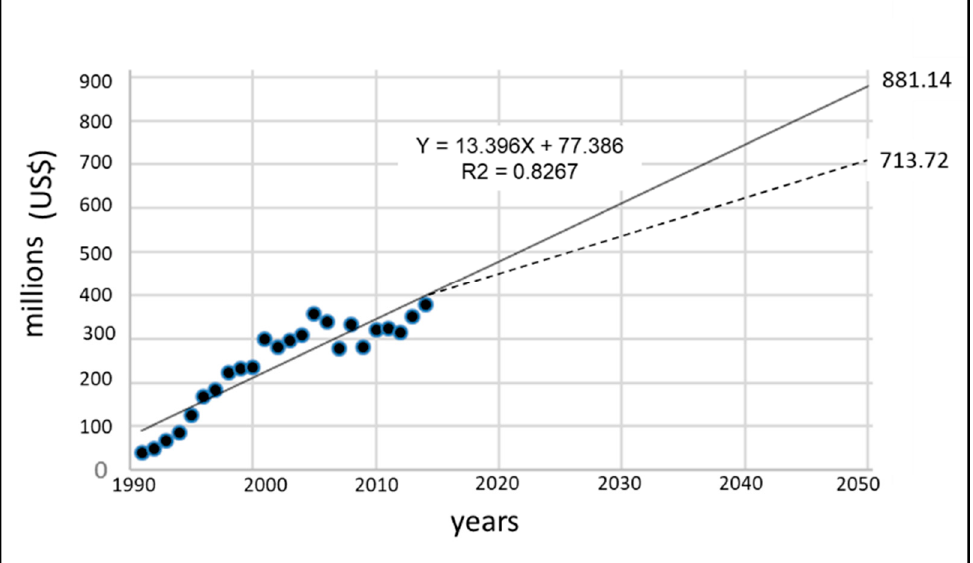
Figure 3. Model projecting the forest production value in 2050. Source: 1993–2016 time series of forest production value [36].